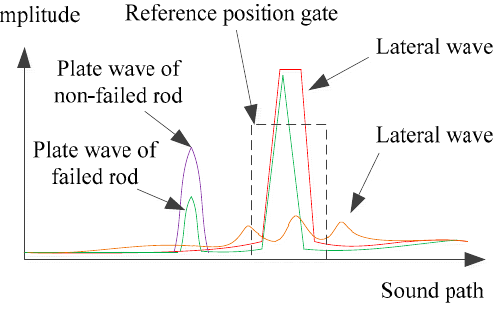
Figure 4. The A-scan signal during scanning process.